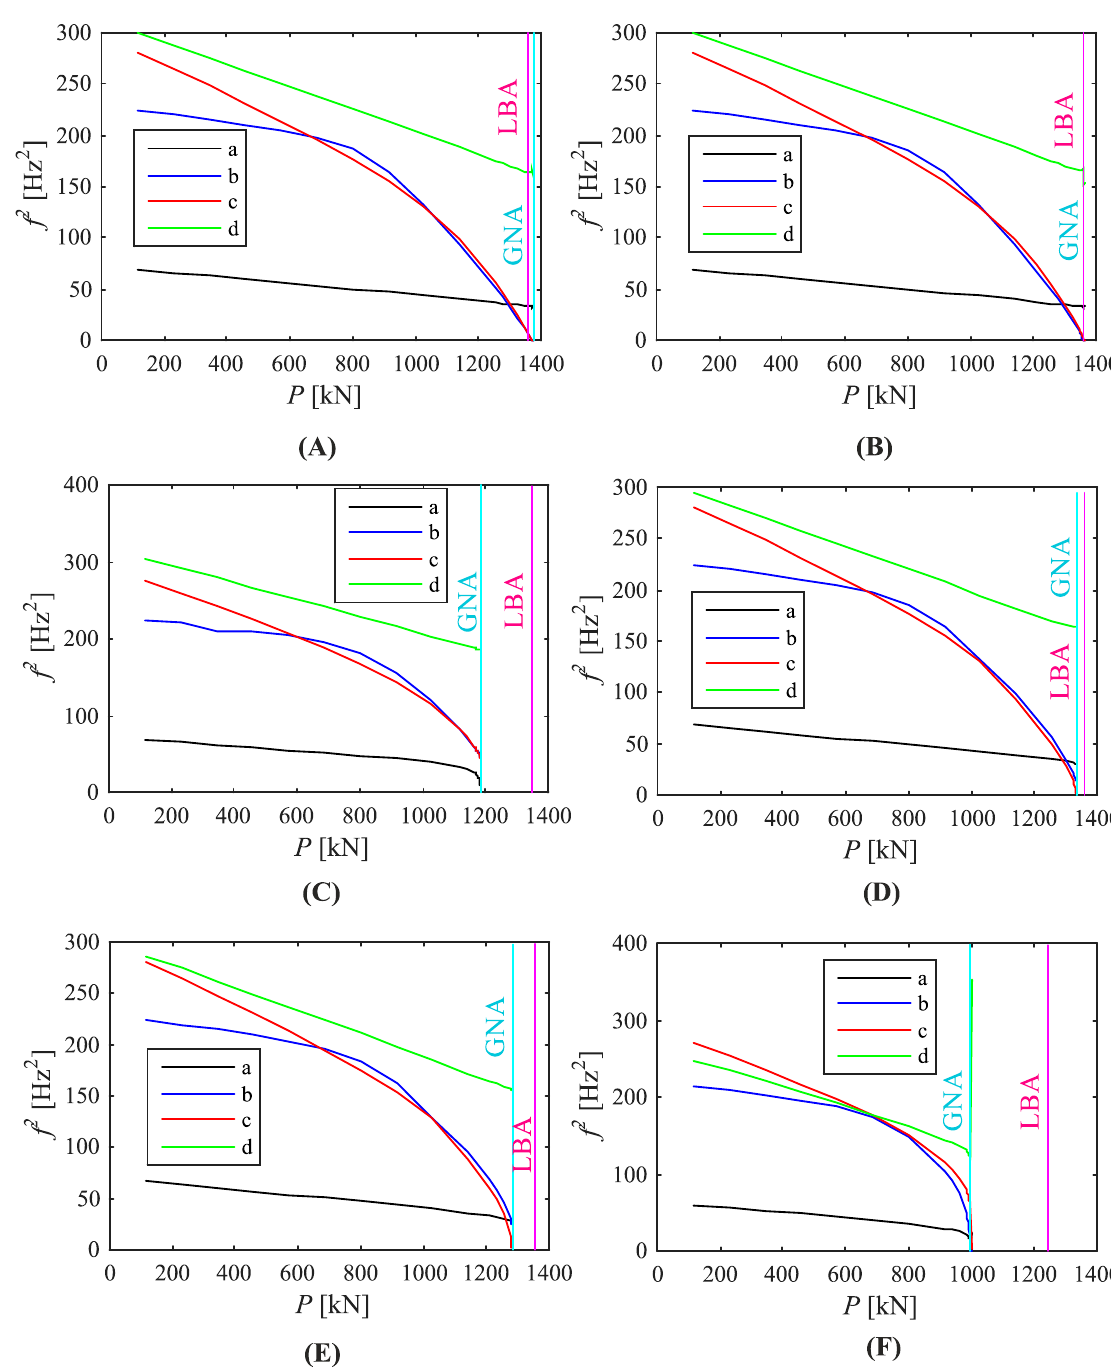
Figure 9. Relationship between applied load and squared natural frequencies ((a) first, (b) second, (c) third, (d) fourth) of the silo segment with initial geometrical imperfections: ( A ) F1_2 mm, ( B ) F1_5 mm, ( C ) F1_20 mm, ( D ) F2_2 mm, ( E ) F2_5 mm, ( F ) F2_20 mm.